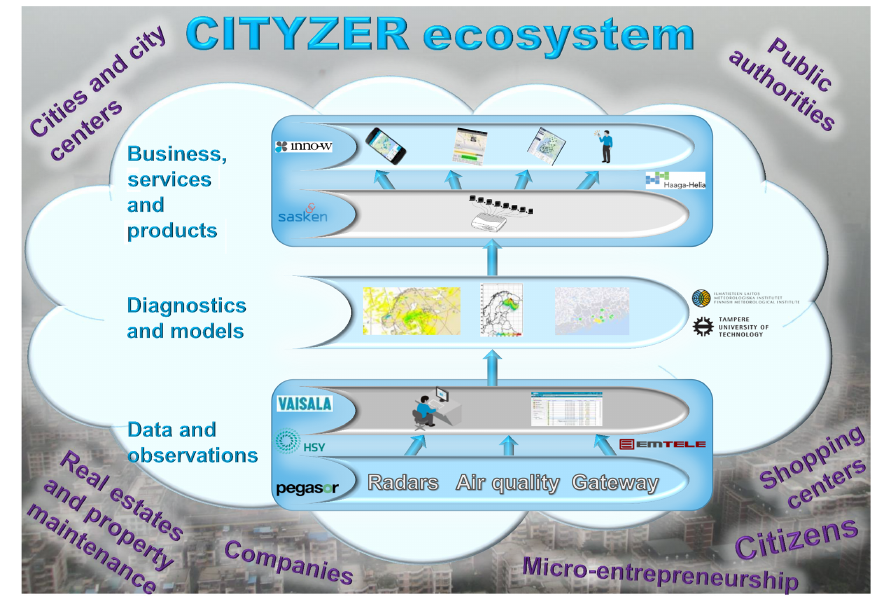
Figure 1. CITYZER